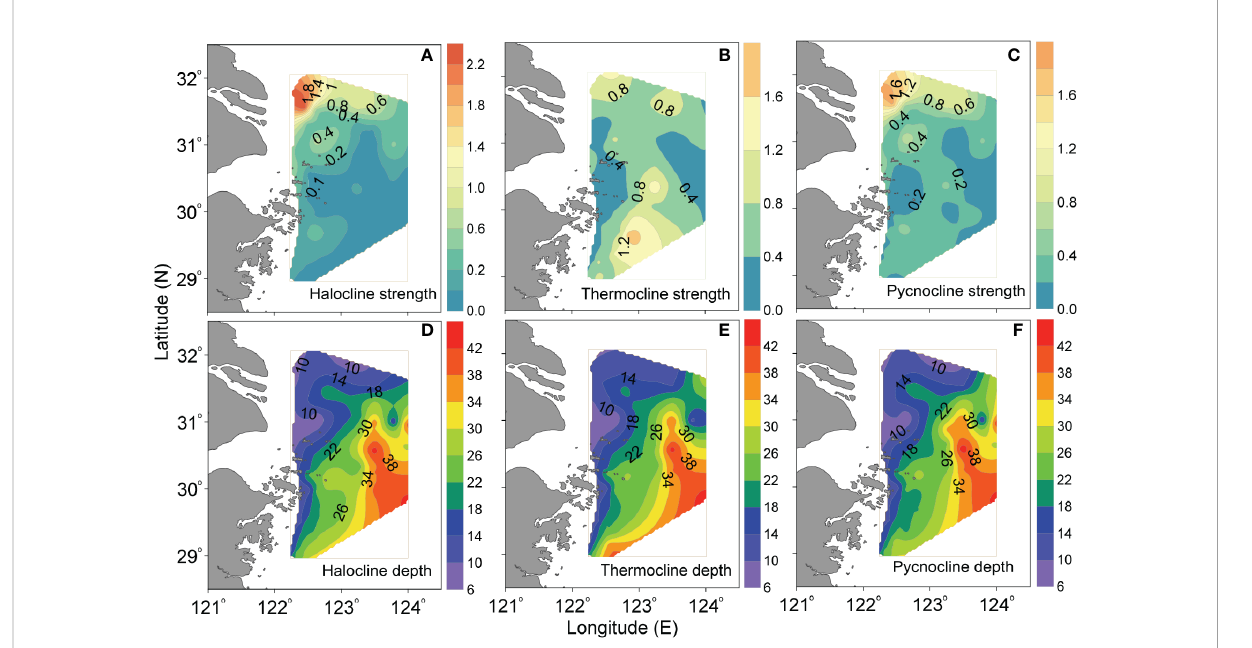
FIGURE 8 Horizontal distributions of the (A – C) strength of halocline (m -1 ), thermocline (°C m -1 ) and pycnocline (kg m -4 ), as well as (D – F) their depths (m) off the CE in August 2013.